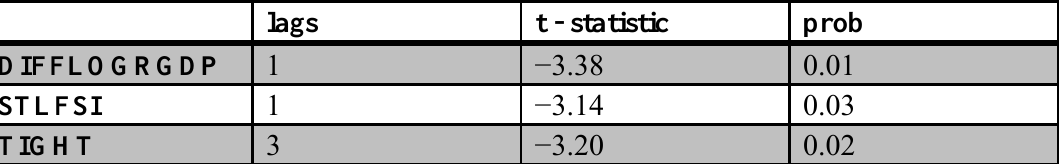
Table 1. Each row contains results of the Augmented Dickey-Fuller test. The number of lags was chosen according to the Akaike criterion.